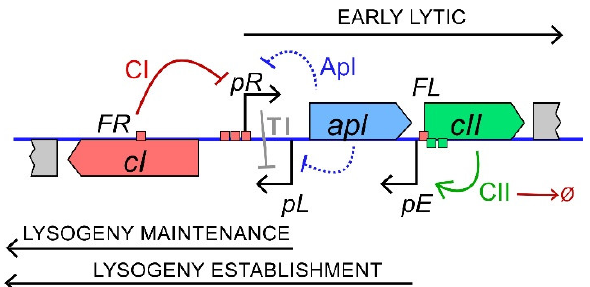
Figure 1. The lytic-lysogenic switch region of bacteriophage 186. Establishment of lysogeny requires the following steps. After infection, pR is on and represses lysogenic transcription by transcriptional interference (TI) with the weak pL promoter. Transcription from pR leads to the production of CII and Apl. CII activates pE to produce CI, while Apl cooperatively represses both pR and pL (dashed lines). If sufficient CI is produced, pR is repressed, lytic development is halted, and the phage enters lysogeny. The transcriptional interference (TI) from pR at pL is alleviated, allowing pL to maintain CI production. CII is subject to degradation by host proteases. The bent arrows represent promoters and the dashed lines represent repression by Apl. The red and green boxes indicate the CI and CII binding sites, respectively.